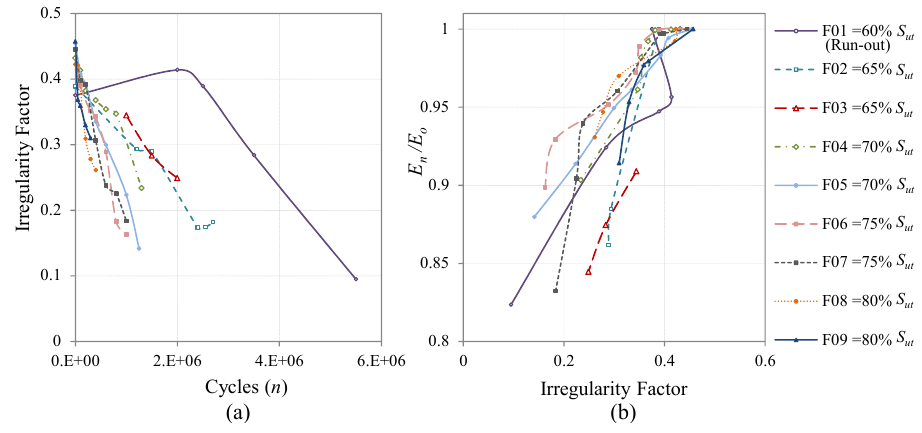
Figure 11. Evolution of the I ‐ Factor of all the coupons cycled with Falstaff. The shown I ‐ Factor for each coupon is the mean value of all the areas of inspection; ( a ) Evolution through the fatigue cycles; ( b ) Relation between the evolution of the stiffness degradation and the evolution of the I ‐ Factor.